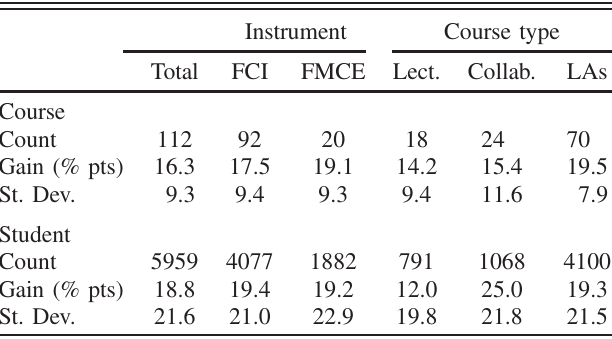
TABLE V. Counts and mean gains by instrument and course type. Mean gains were examined at the course level through aggregation and student level through disaggregation. Course types were lecture (Lect.), collaborative without LAs (Collab.), and collaborative with LAs